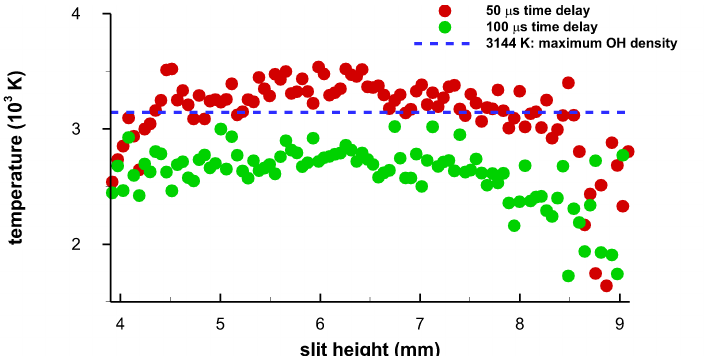
Figure 16. Temperature versus slit height for time delays of 50 µ s and 100 µ s. The horizontal dotted line indicates the temperature of 3144K at which the OH density maximizes to 3.17 × 10 16 cm − 3 .